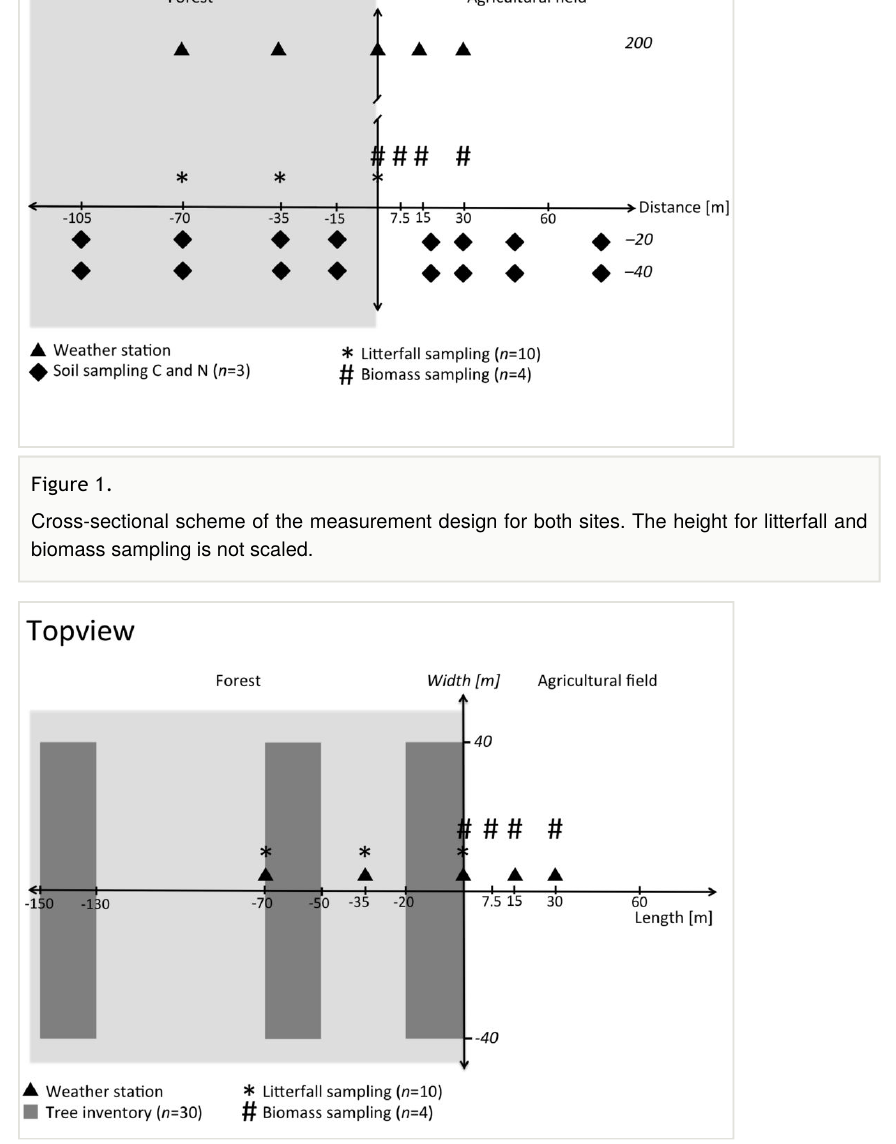
Figure 2. Topview on to the measurement design for east-facing site. The west-facing site is mirrored. The width is only scaled to the forest inventory plots. The symbols for weather stations, litterfall and biomass sampling are o ff